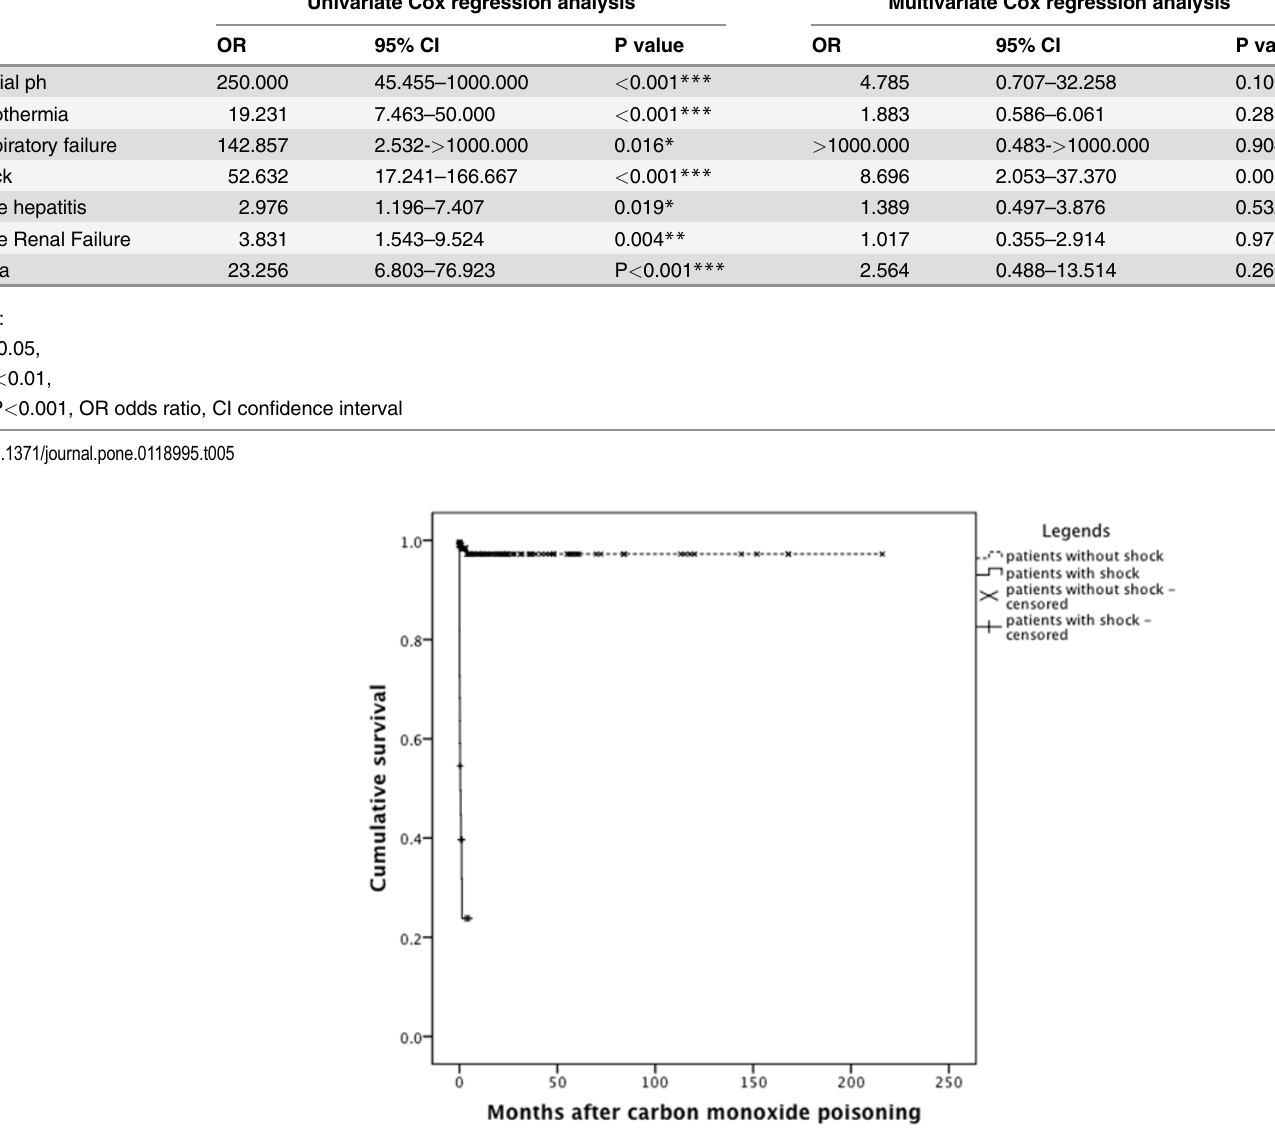
Fig 1. Kaplan-Meier analysis. It was found that patients with shock suffered greater cumulative mortality than patients without shock (Log-rank test, Chi-square 147.404, P < 0.001).